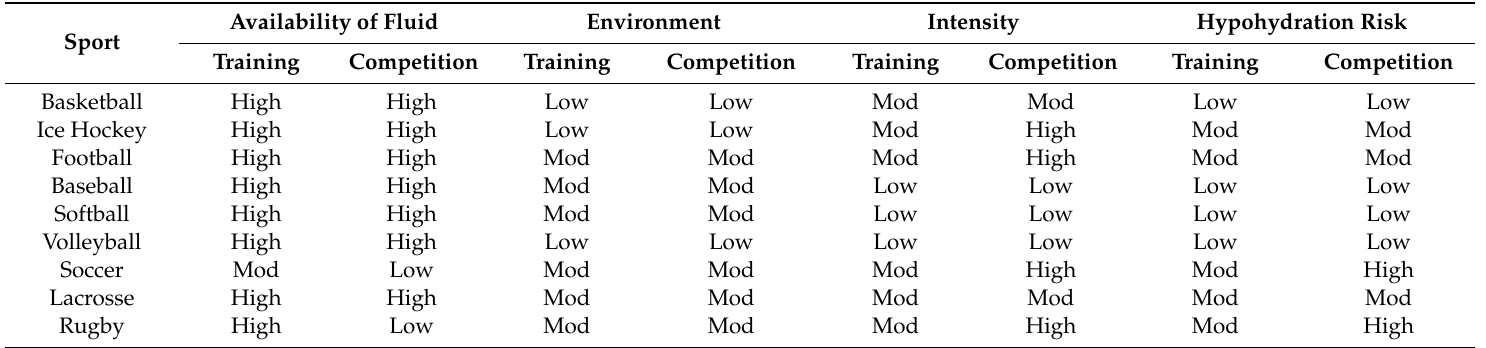
Table 1. Team Sport Factors That Influence